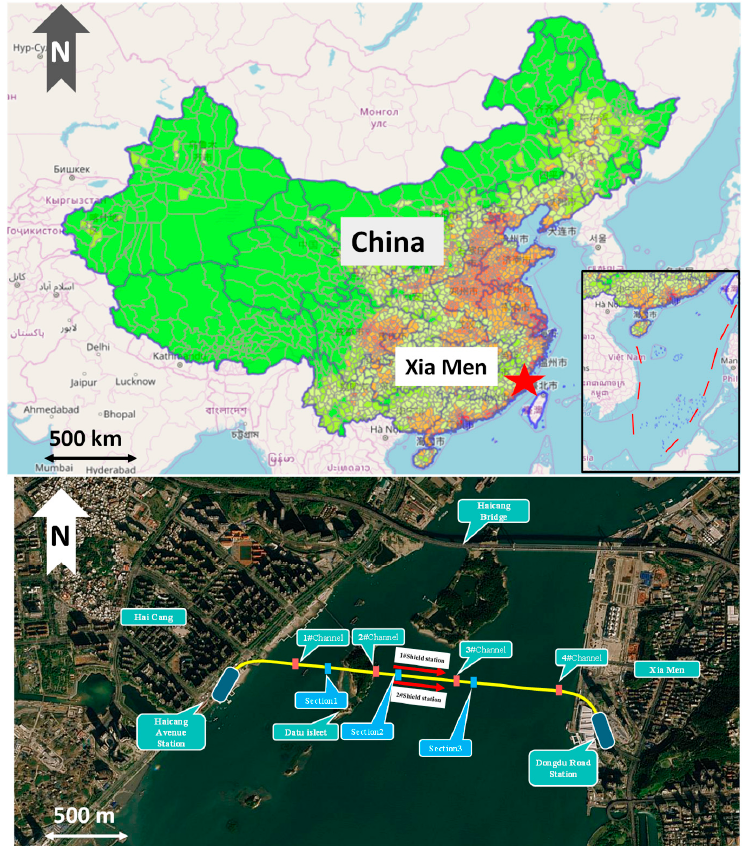
Figure 1. Area of construction works.